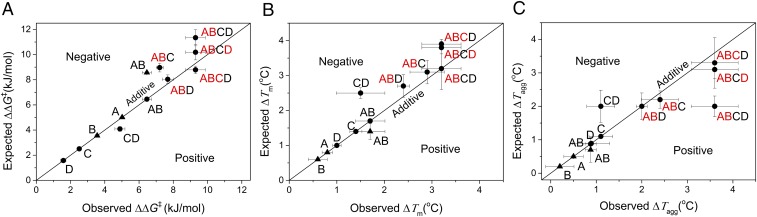
Analysis of epistatic interactions among all of the point mutations based on kinetic and thermodynamic stability. Quantitative analysis of epistatic interactions among the mutations with the ΔΔG‡ as the fitness A, with the ΔTm as the fitness B, and with the ΔTagg as the fitness C. y = x diagonal reflects the additive effect between two mutations. ABCD could be formed from combinations of AB+CD, C+ABD, D+ABC, and so each combination was indicated by red for the starting variant and black for the new mutation. All of the mutants were represented by letters, and the two evolutionary phases starting from WT, with phase 1 (▲), A—H192P, B—A282P, AB—H192P/A282P; and phase 2 (●), C—Il365L, D—G506A, AB—H192P/A282P, CD—I365L/G506A, ABC—I365L/H192P/A282P, ABD—G506A/H192P/A282P, and ABCD—I365L/G506A/H192P/A282P.